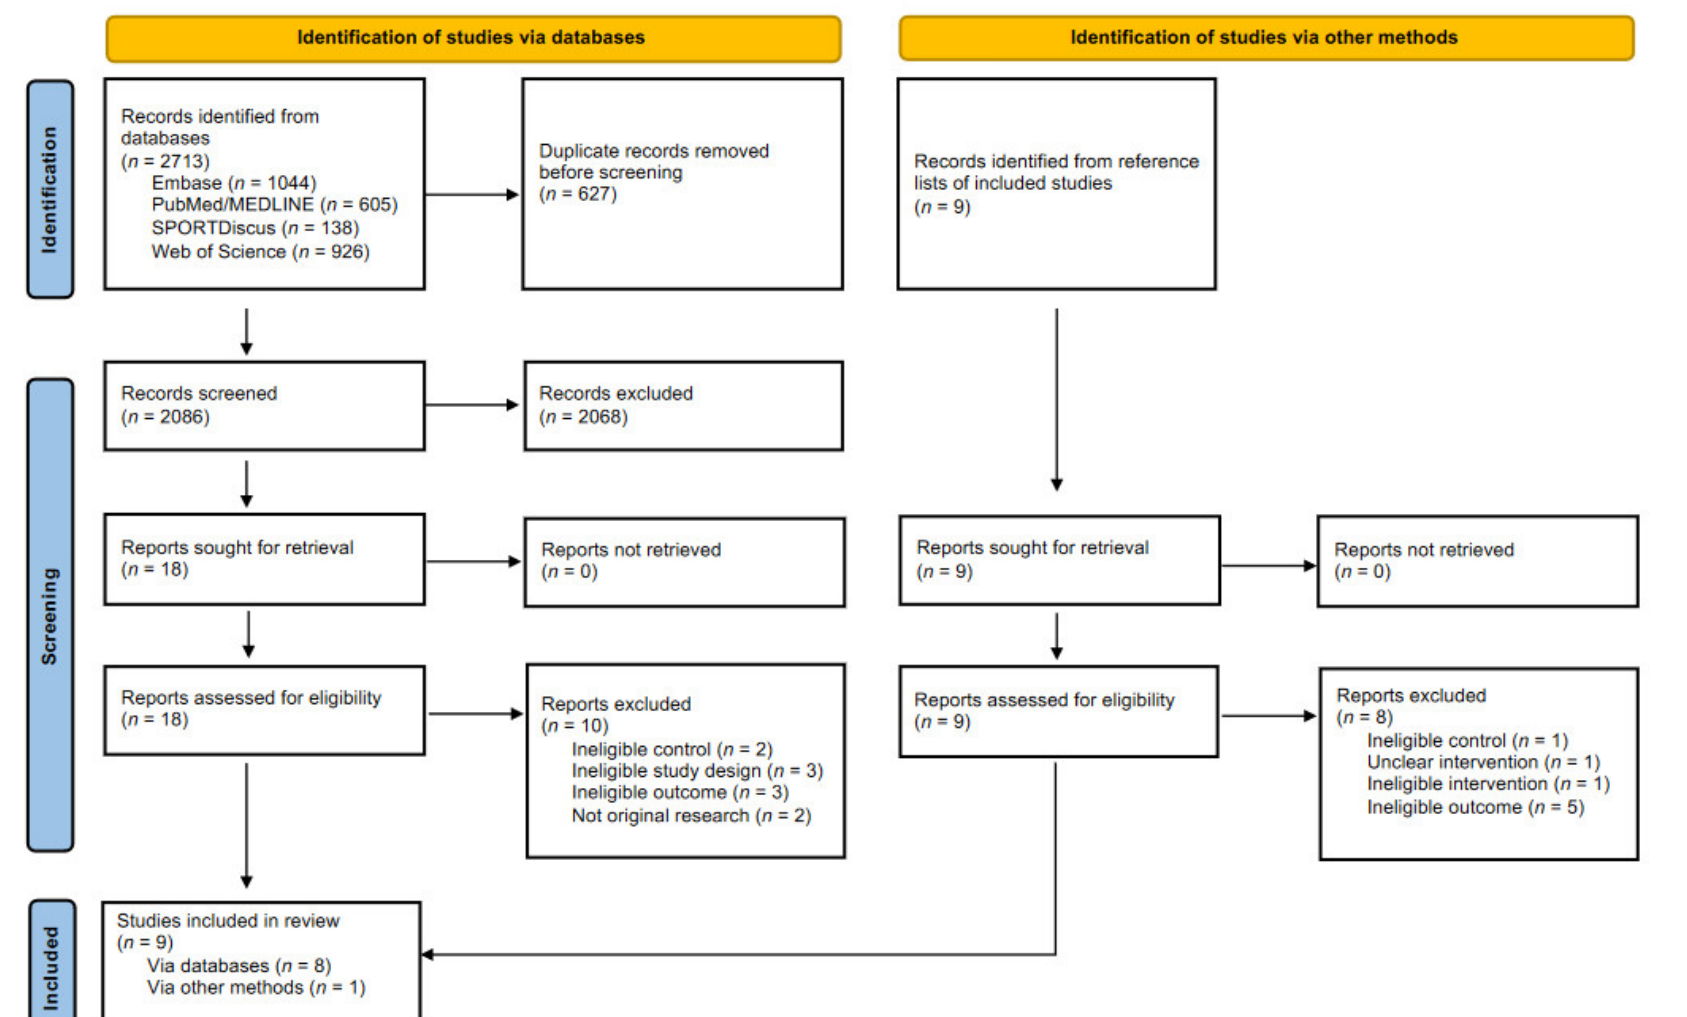
Figure 1. PRISMA 2020 flow diagram for new systematic reviews which included searches of databases and other methods [22].